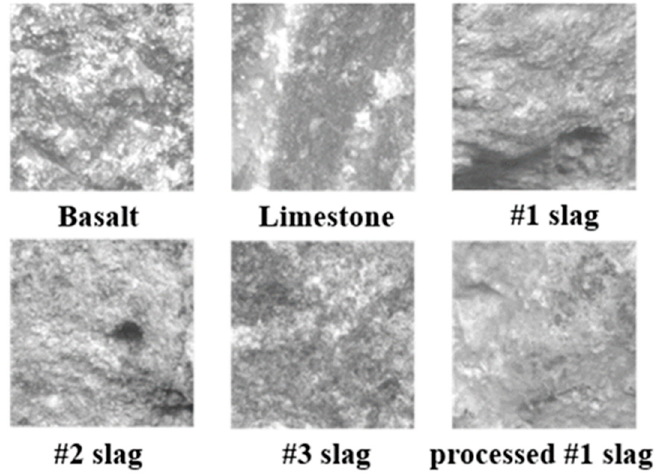
Figure 8. Parts of the surface texture images of aggregates.